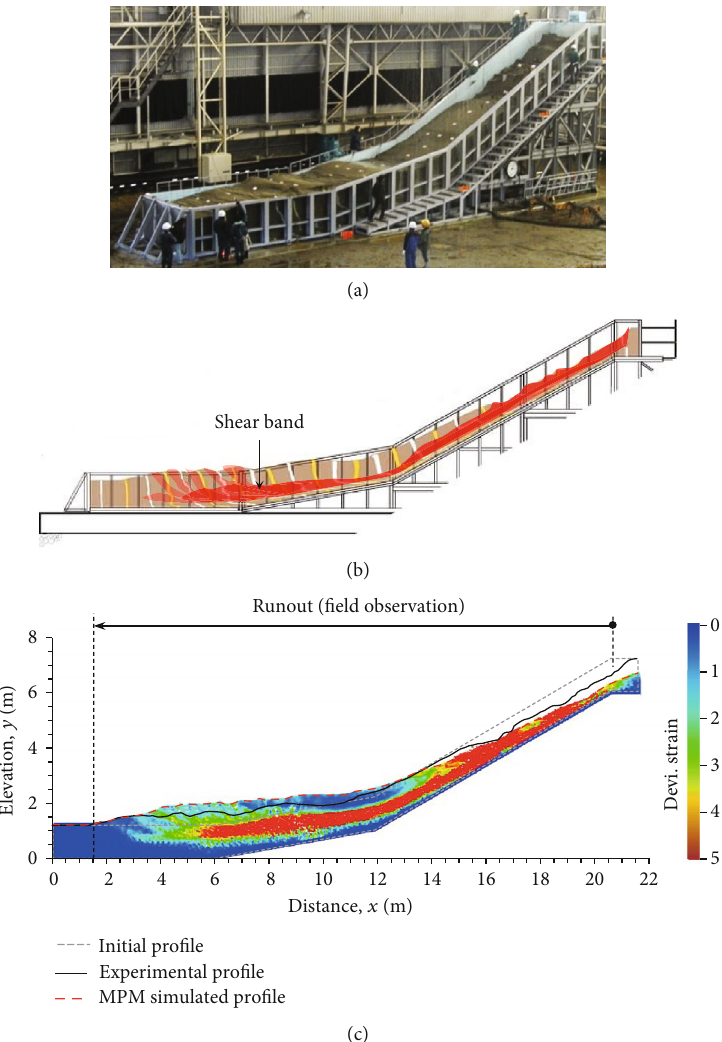
Figure 4: Comparison of predicted and measured fi nal con fi guration and development of shear band: (a) photo of the experiment, (b) illustration from experiment results, and (c) prediction by